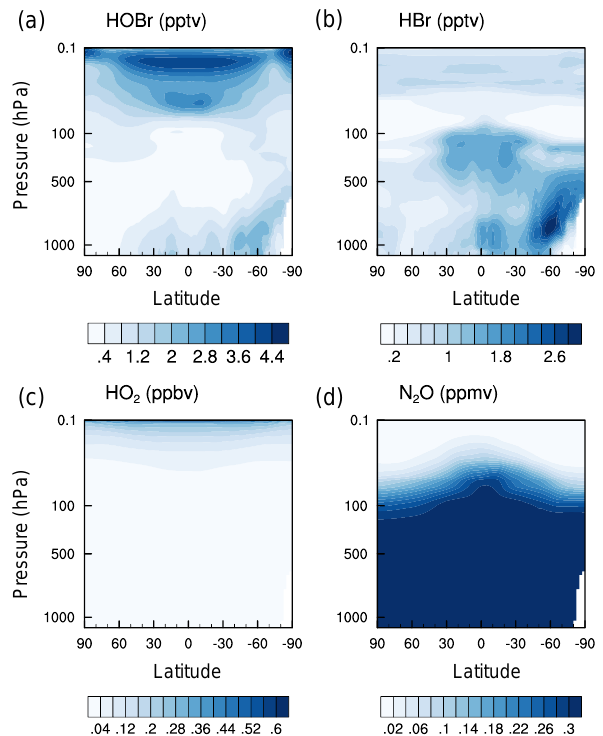
Figure 5. Zonal mean vertical concentrations for (a) HOBr, (b) HBr, (c) HO 2 and (d) N 2 O produced by the stratospheric config- uration of the UM-UKCA and interpolated to a fixed pressure grid. Data shown are the 2012 annual average. Note the different label bars and